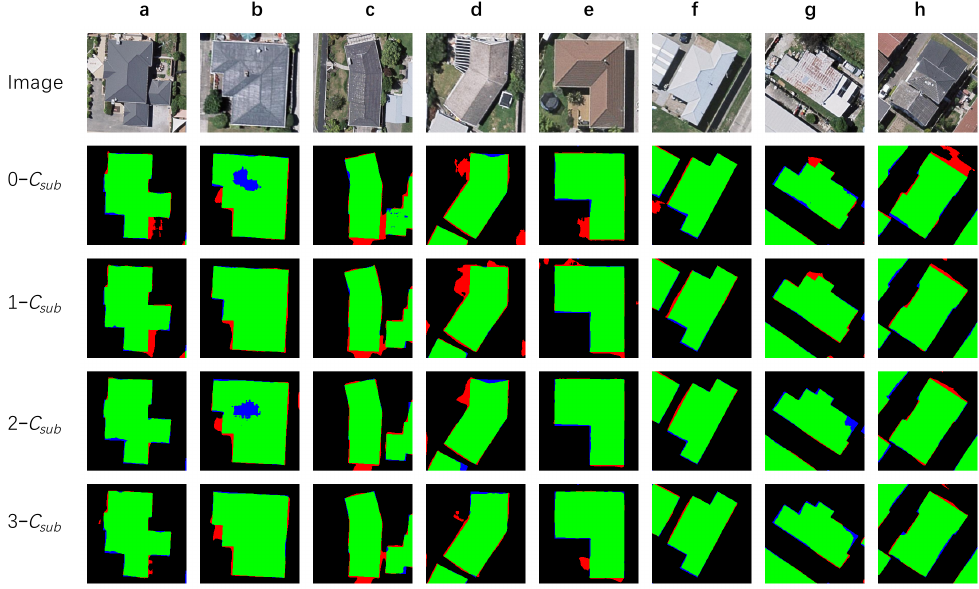
Figure 8. Representative results of building segmentation through MC–FCN models with variant numbers of subconstraints. The green, red and blue channels of results represent true positive, false positive and false negative predictions, respectively, of every